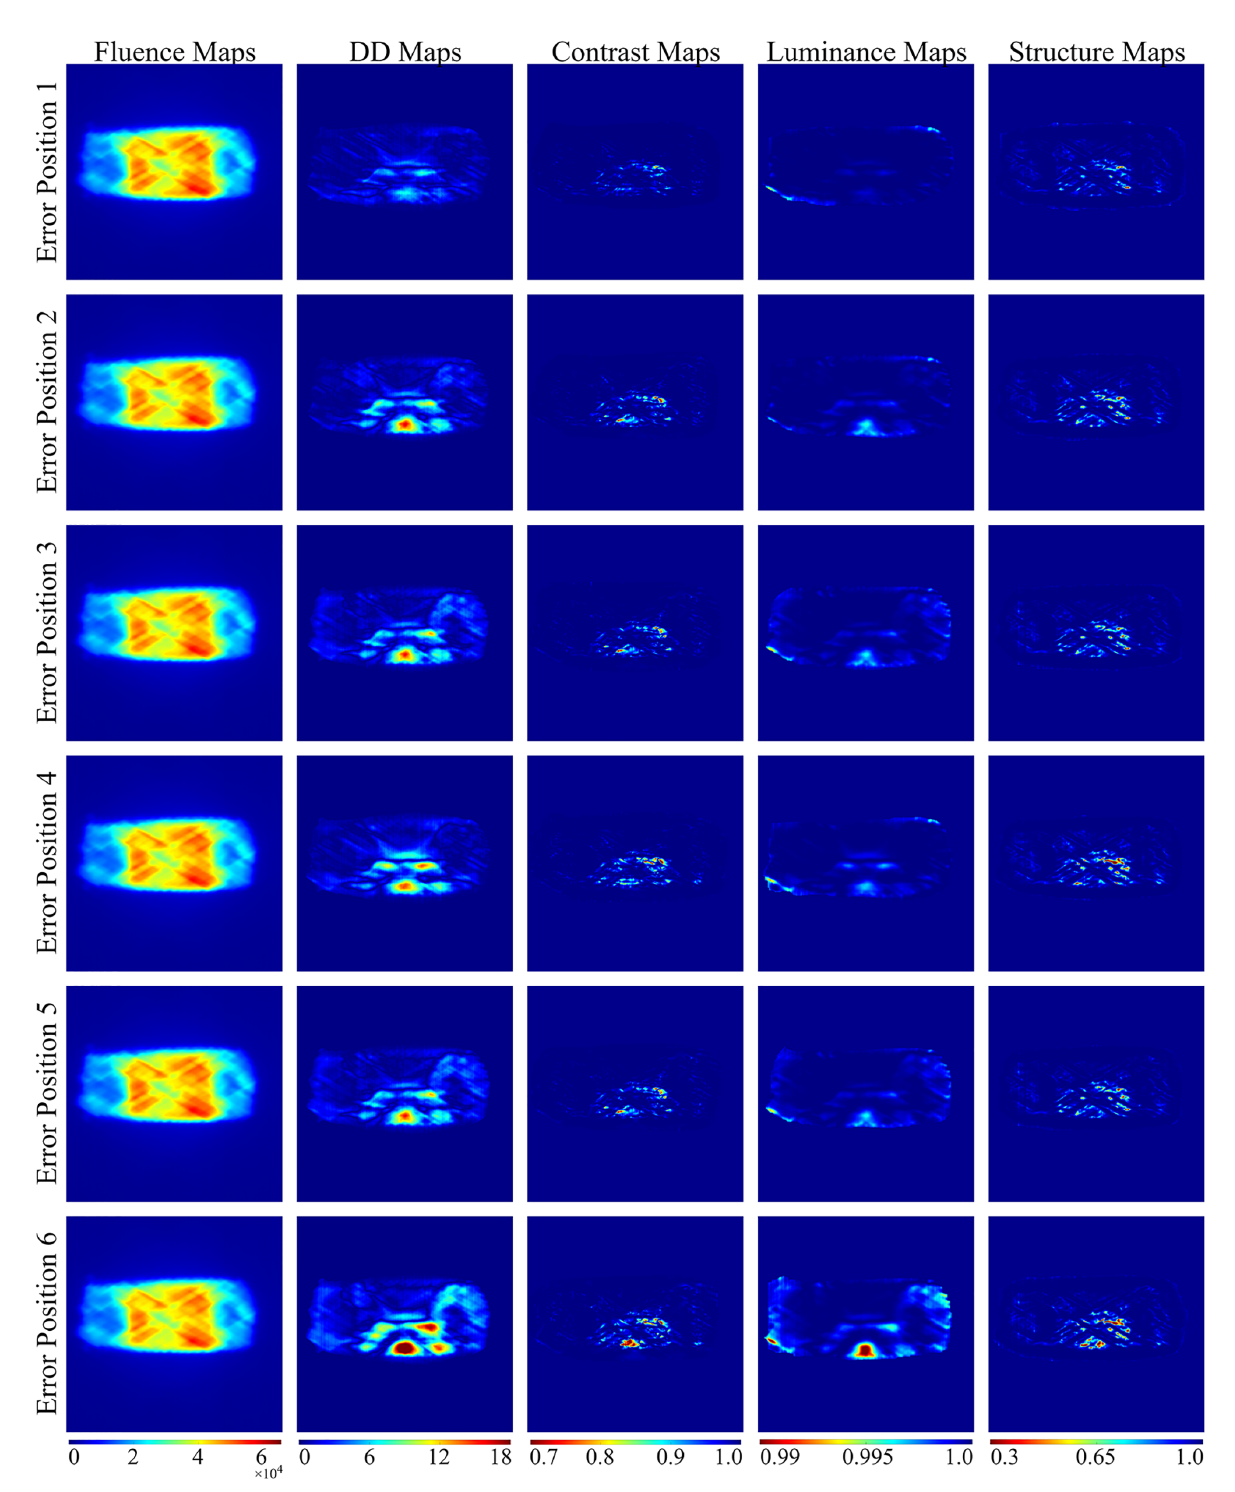
Frontiers in Oncology |